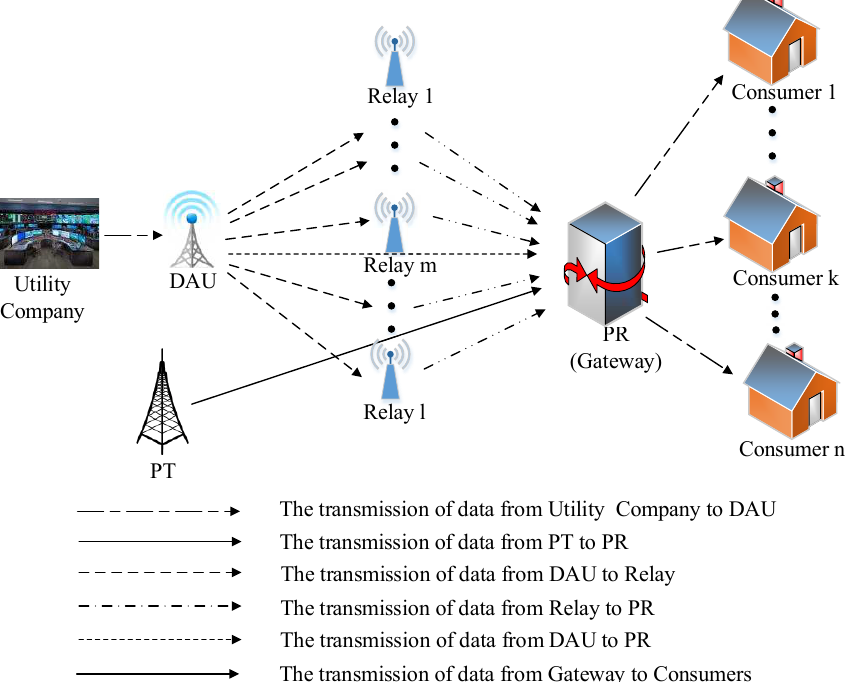
Figure 1. The cognitive wireless network in a smart